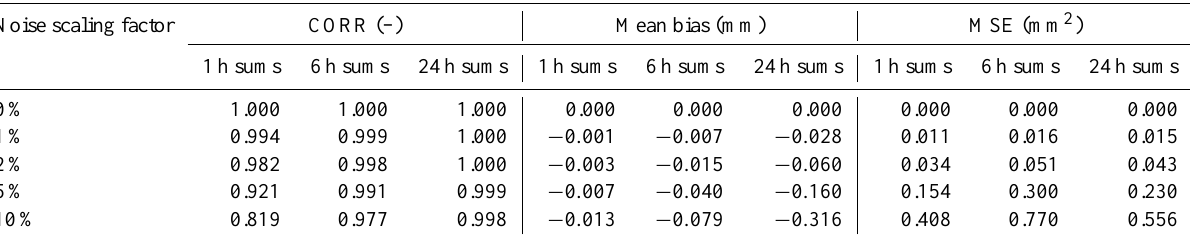
Table 6. Correlation (CORR), mean bias and mean squared error (MSE) for different temporal aggregation lengths between observed and inferred precipitation of the virtual experiments in which different magnitudes of noise were added to the input runoff data. These are indicated with the noise scaling